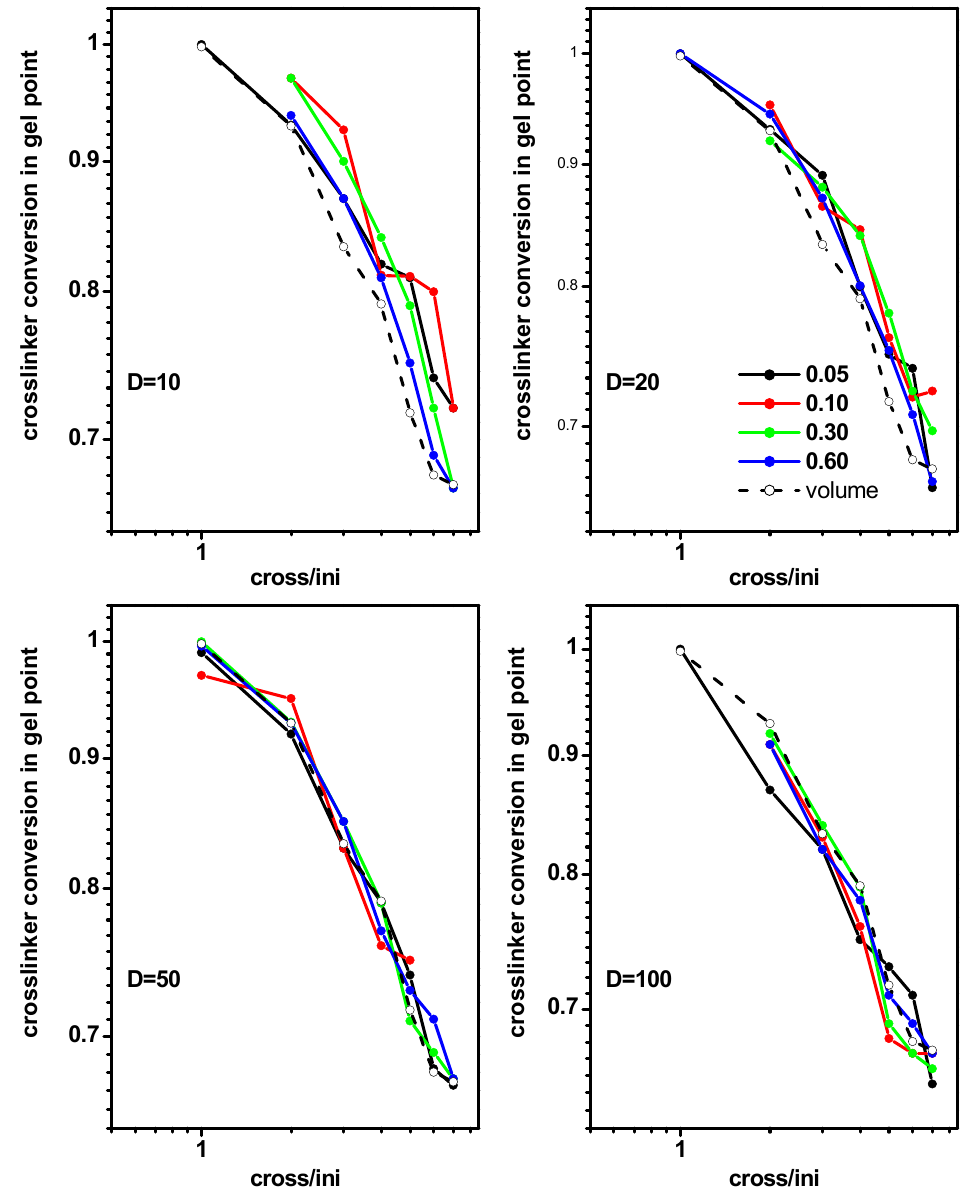
Figure 7. Cross-linker conversion at the gel point for polymerization in a slit, as a function of the ratio [Ini]/[X] for different widths of the slit. The initiator densities are given in the inset. The cross-linker conversion at gel point for a free volume is marked by the dashed line.